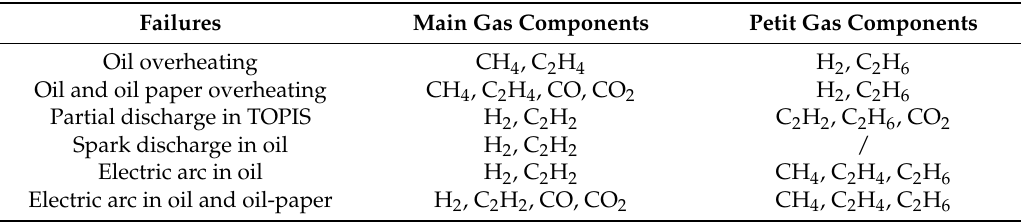
Table 1. Gases generated by different failure